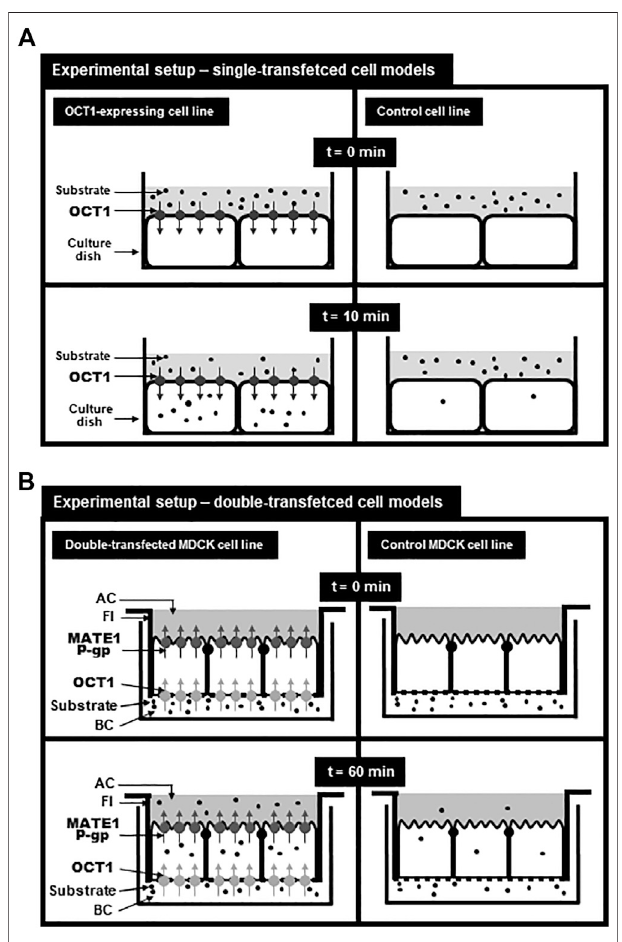
FIGURE 1 | Experimental setup for using single-transfected (A) and double-transfected (B) cellmodelsmodi fi edfromTaghikhanietal.(Taghikhani et al., 2017). (A) : Setup for analyzing the transport function of OCT1 in single- transfected cell lines. At time point 0 min, the donor solution containing the substrate is applied onto the cell layer and after 10 min, the uptake of the substrate into OCT1-expressing cells and into control cells can be determined.Bysubtractingtheuptakeintothecontrolcelllinefromtheuptake into the OCT1-expressing cell line, the so called net uptake can be calculated referring to the uptake mediated by recombinantly expressed OCT1. (B) : Setup for vectorial transport assays using double-transfected MDCK cell lines expressing OCT1 in the basolateral membrane and MATE1 or P-glycoprotein in the apical membrane. MDCK cells were cultured on fi lter inserts (FI) separating abasolateral (BC) from anapical (AC) compartment.The substrate was added to the basolateral compartment and after 60 min the substrate concentration in the cells (uptake) or in the apical compartment (vectorial transport) can be calculated and compared to the uptake or the vectorial transport of the control MDCK cell line. Net intracellular substrate concentrations re fl ects OCT1-mediated substrate uptake and the net substrate concentration in the apical compartment re fl ects the vectorial transport mediated by OCT1-mediated uptake and MATE1-or P-gp- mediated